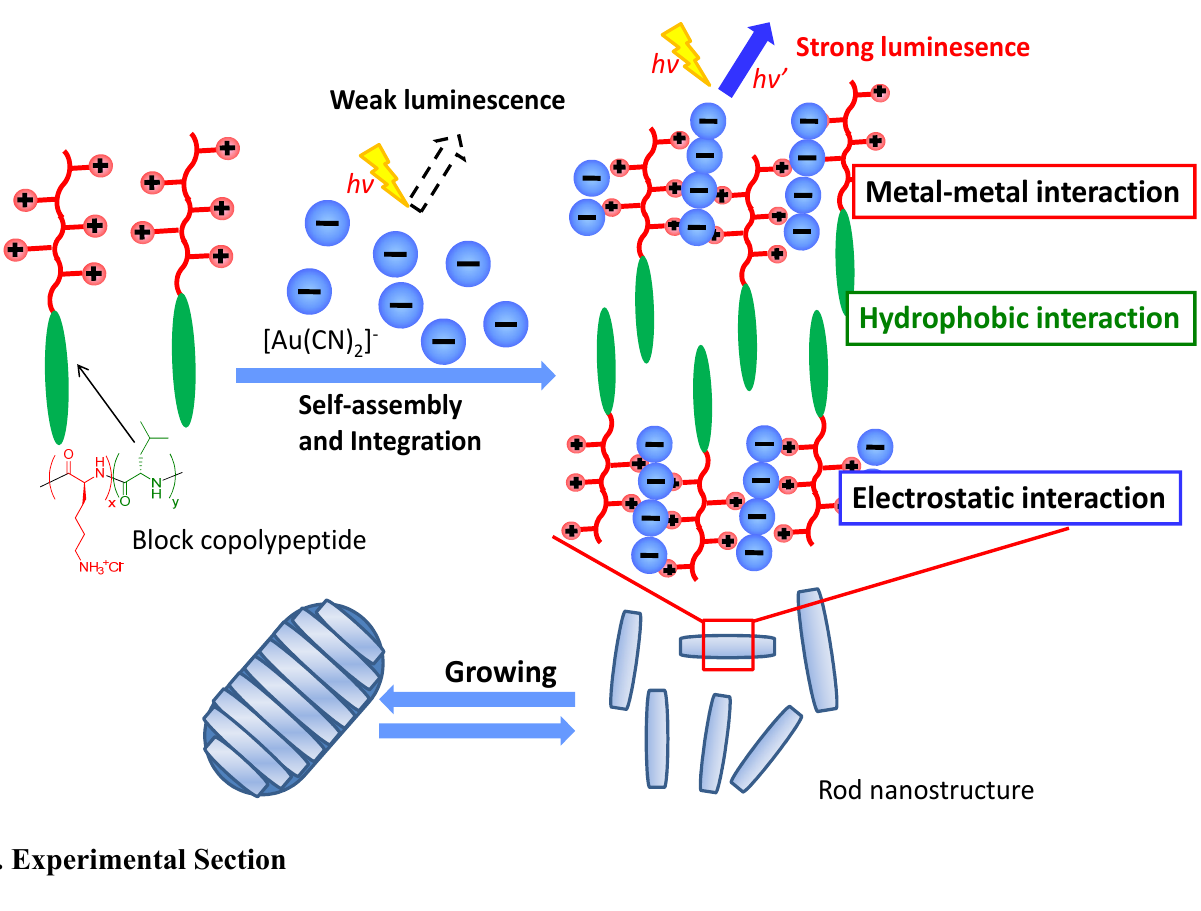
Figure 8. Schematic illustration of self-assembly of copolypeptide amphiphiles/Au complexes to develop the functional